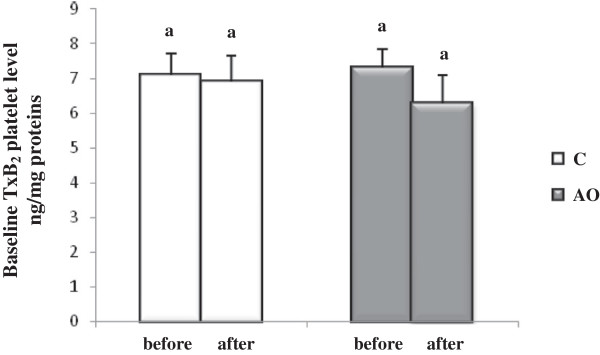
Platelet thromboxane B2 (TxB2) level after 3 weeks of nutritional intervention with argan oil. Comparisons are made between the platelet TxB2 level before and after the intervention period in the two groups. C: control group; AO: argan oil group. After a one-way ANOVA, Student-Newman-Keuls multiple comparison test, results are arranged in increasing order from left to right a > b (p < 0.05).